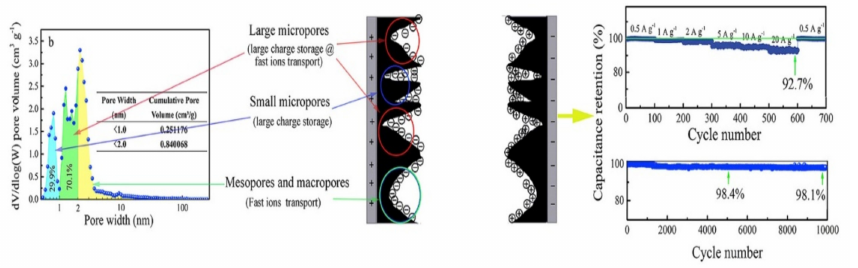
Figure 3. Influence of the pore size on the electrochemical properties of SCs [37]. Figure reproduced with permission from Elsevier,